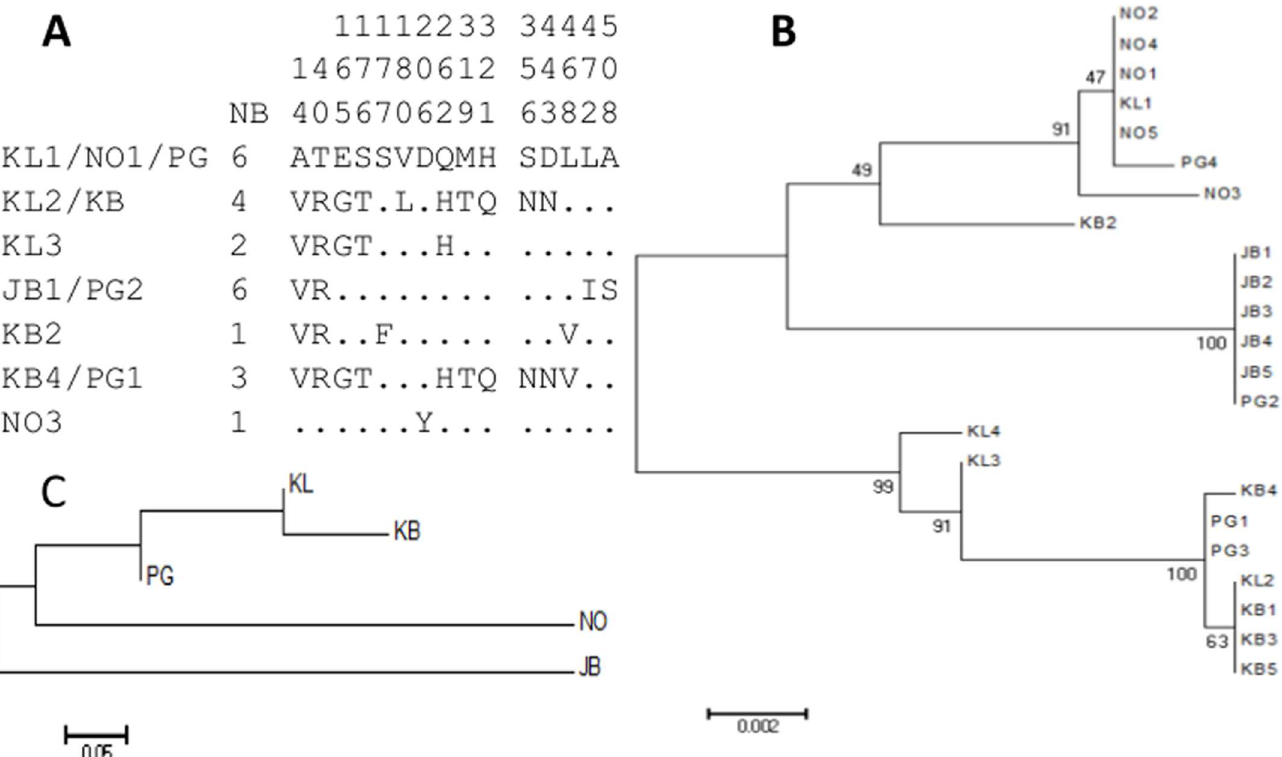
Fig 2. Genetic diversity of CYP9J27 across Malaysianpopulations of Aedes aegypti . A) Schematic representation of CYP9J27 haplotypes from across Malaysia and in the NO susceptible strain. The polymorphic positionsfor CYP9J27amino acid sequencesare highlighted.A numberis given to each haplotypeprecededby locationorigin (KL, KB, JB, PG and NO, for Kuala Lumpur, Kota Bharu, Johor Bharu, Penangand New Orleans, respectively). The column Nb stands for the numberof individualmosquitoessharing a haplotype. B) Neighborjoiningtree of CYP9J27 haplotypes. C) Genetic distancetree betweenthe different samples based on the Nst genetic